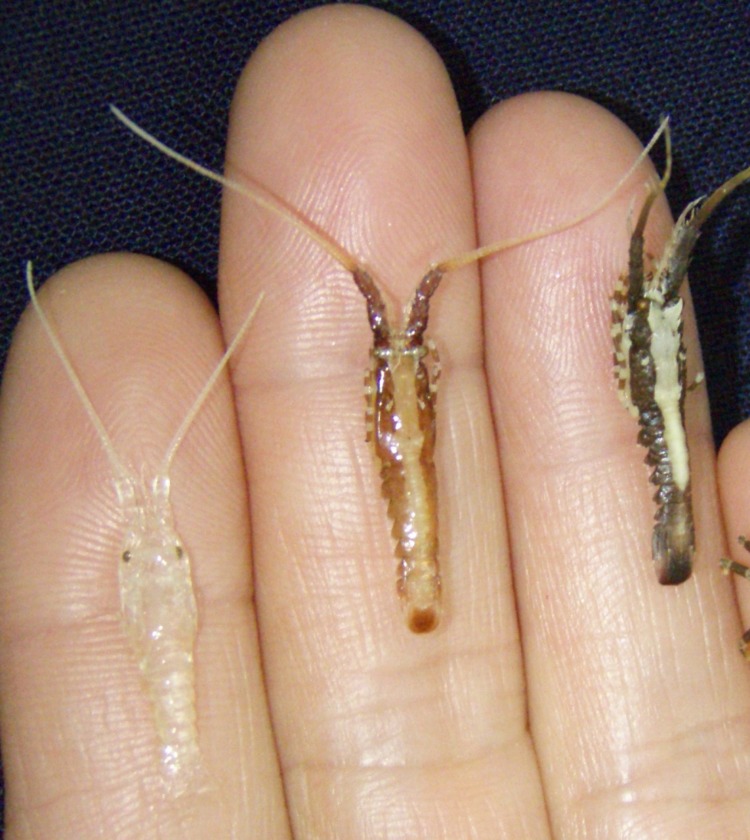
Developmental stages of Panulirus argus considered in the present study.From left to right: transparent puerulus, pigmented puerulus, and first-stage juvenile of the Caribbean spiny lobster Panulirus argus. The term “pueruli” in the text refers to transparent + pigmented pueruli. (Photo: F Negrete-Soto, with permission).